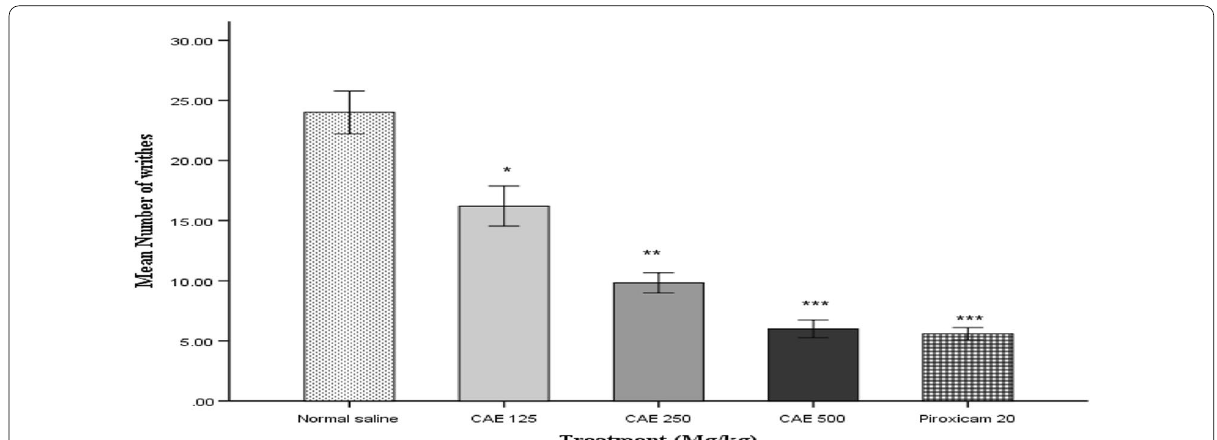
Fig. 1 Action of MECA on acetic acid-induced writhes test. The values were analysed by One-Way ANOVA followed by Bonferroni post hoc test and presented as mean